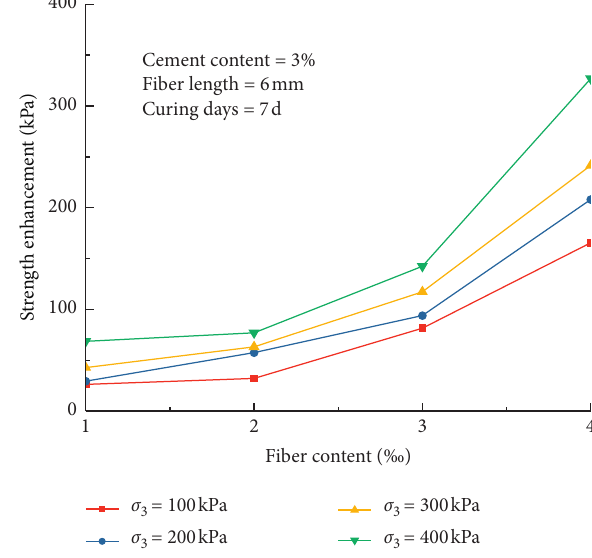
Figure 8: Effect of fiber content on volumetric strain-axial strain